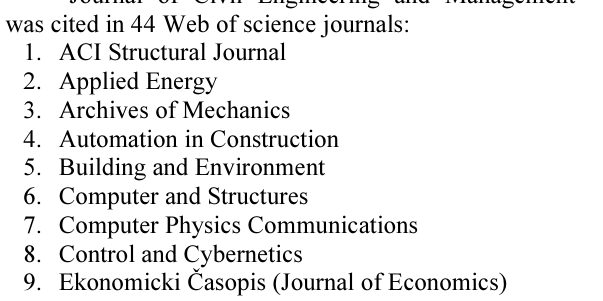
Fig. 3. Accumulative increment of “Journal of Civil Engi- neering and Management” papers cited in ISI Web of sci- ence